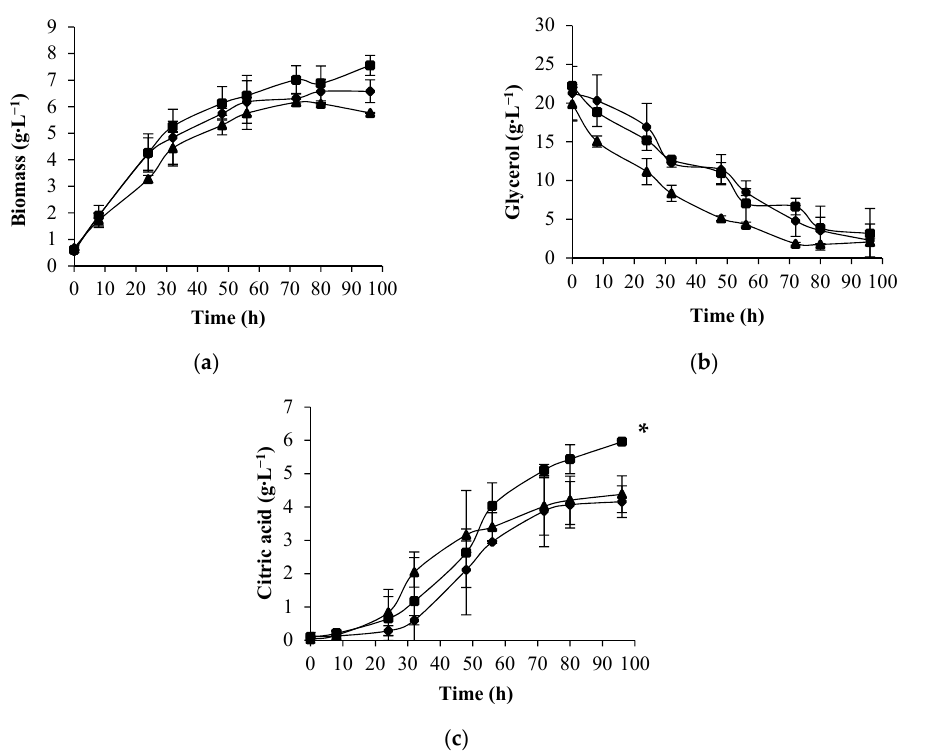
Figure 2. Biomass concentration ( a ), glycerol consumption ( b ), and citric acid production ( c ) in batch cultures of Y. lipolytica W29 at 1 bar ( ♦ ), 2 bar ( ■ ), and 4 bar ( ▲ ) of total air pressure. The error bars represent the standard deviation of two independent replicates. * Statistically different ( p < 0.05).